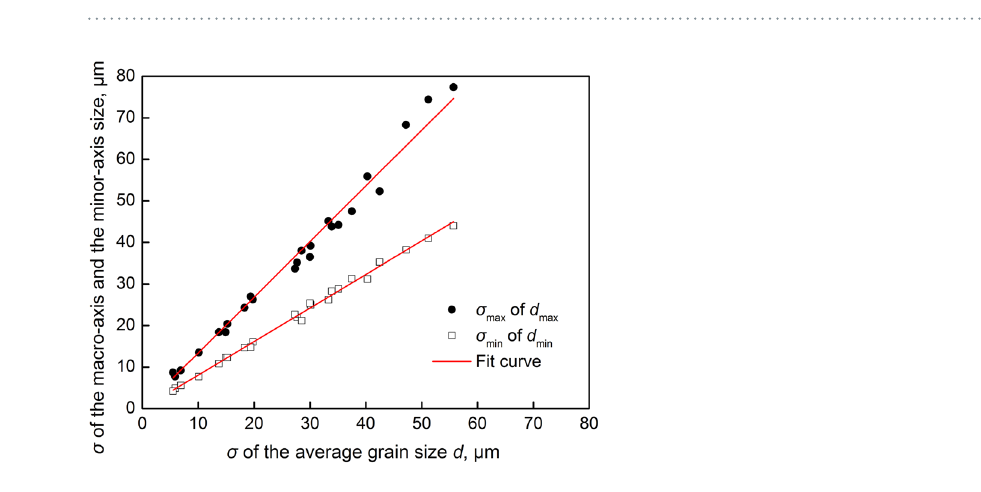
Figure 10. The relationships between the macro-axis and minor-axis size with the average size.